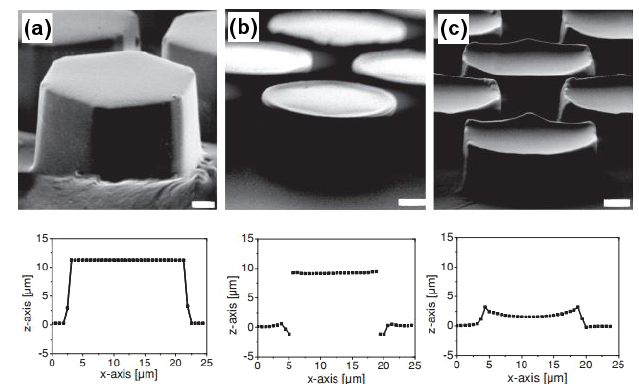
Figure 18. Biomimetic hexagonal surface textures. Scanning electron microscopy (SEM) images of polydimethylsiloxane (PDMS) arrays of hexagonal micropillars (15–19 µ m diameter) terminated with ( a ) flat tips, ( b ) T-shaped tips (10 µ m height, 3 and 5 µ m channel width) and ( c ) concave tips (3 µ m height, 5 µ m channel width). Scale bars correspond to 2 µ m. Below, the corresponding profiles of pillars as obtained with confocal microscope are shown